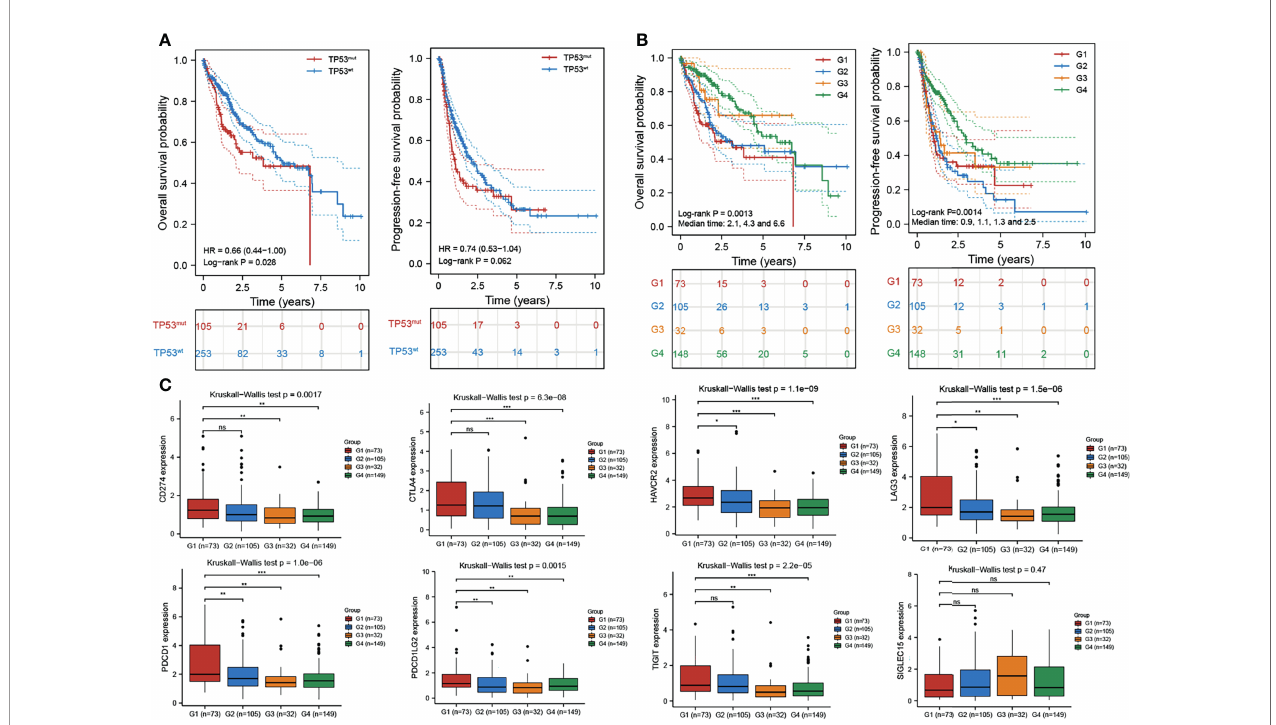
FIGURE 10 | Combined analysis of H2AFZ expression and TP53 status improves prognostic value of HCC patient outcome. (A) Overall survival and progression- free survival of TP53 mut and TP53 wt patients. (B) Overall survival and progression-free survival of the four subgroups (G1: H2AFZ high /TP53 mut ; G2: H2AFZ high /TP53 wt ; G3: H2AFZ low /TP53 mut ; G4: H2AFZ low /TP53 wt ). (C) Expression levels of immune-checkpoint-relevant transcripts in the four subgroups, respectively *p < 0.05; **p < 0.001; ***p < 0.0001; ns, not signi fi